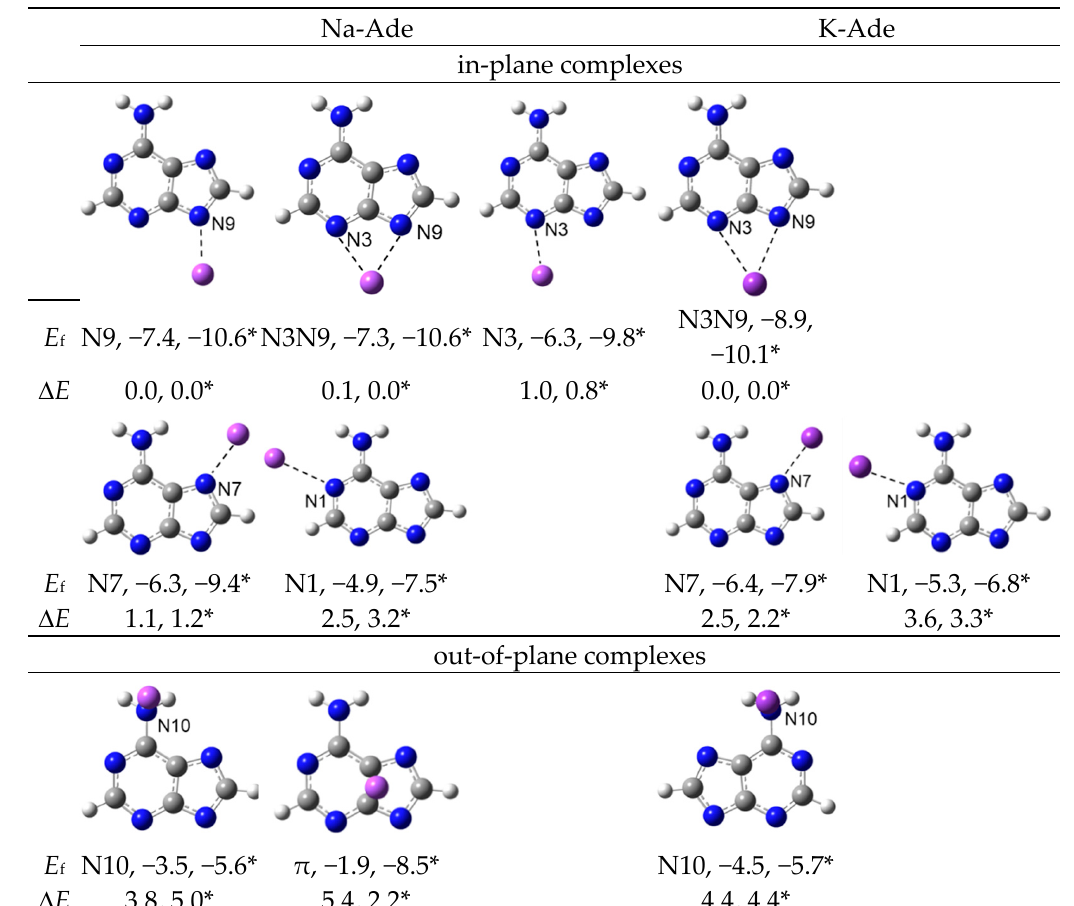
Figure 1. CCSD-optimized structures and corresponding energies of formation ( E f ) and the electronic energy differences ( ∆ E ), both in kcal mol − 1 . ∆ E values were computed relative to the lowest energy conformers, i.e., N9-CIP for the Na-Ade complex and N3N9-CIP for the K-Ade complex. For comparison, the DFT values, marked with an asterisk, are also provided.